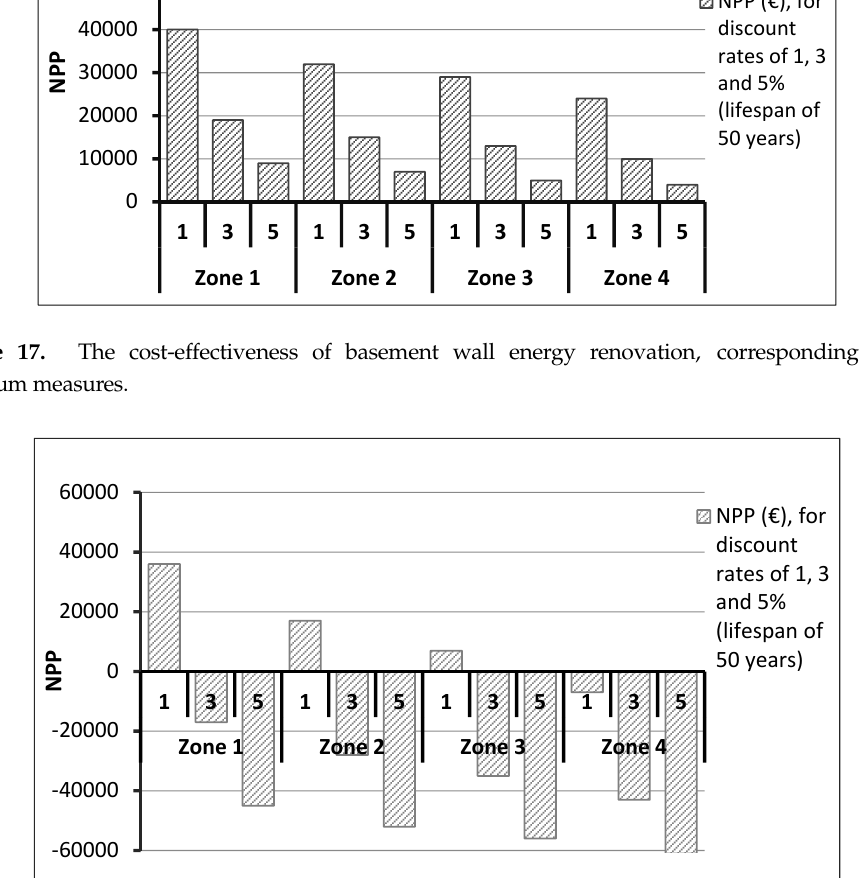
Figure 18. The cost ‐ effectiveness of exterior walls energy renovation, corresponding to the optimum measures. Buildings 2017 , 7 , x FOR PEER REVIEW